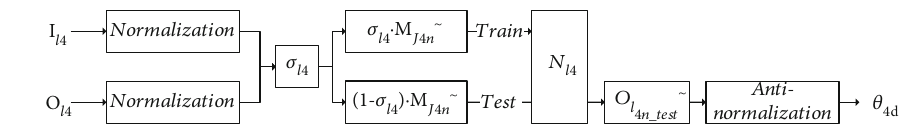
Figure 10: Training process of the manipulator control network N